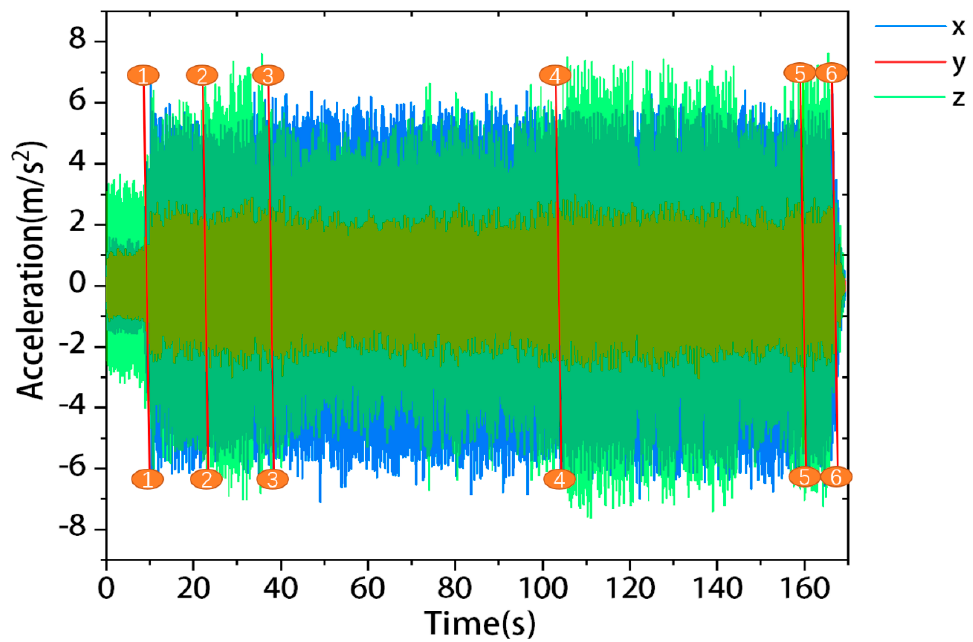
Figure 18. Time–frequency diagram of the static no-load and chipping process of the carrier platform of the chipper.